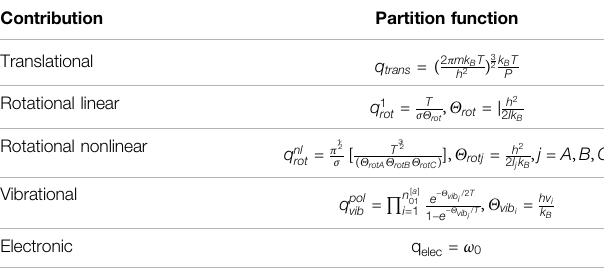
TABLE 1 | Contributions to the partition function. Contribution Partition